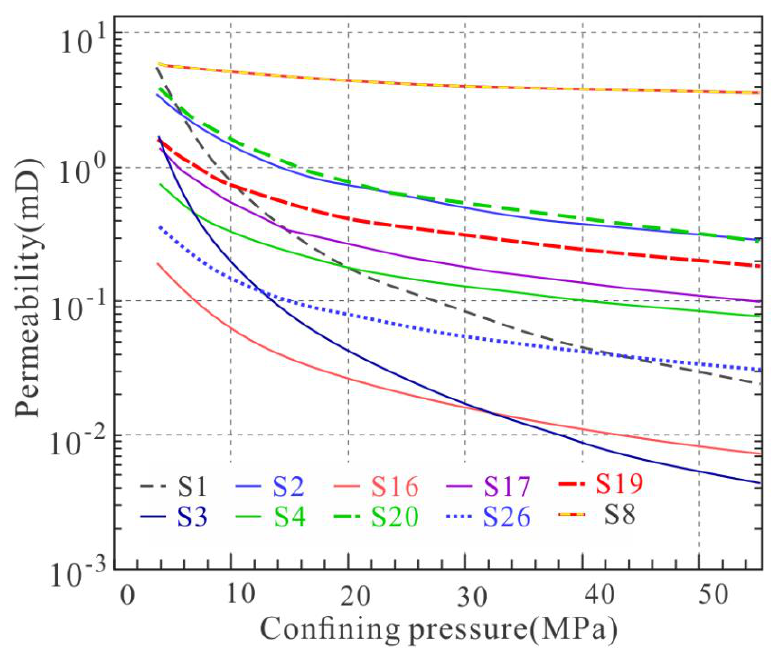
Figure 6. Predicted correlations (Appendix B) between permeability and confining pressure based on the measured data shown in Figure 4 and listed in Appendix A.